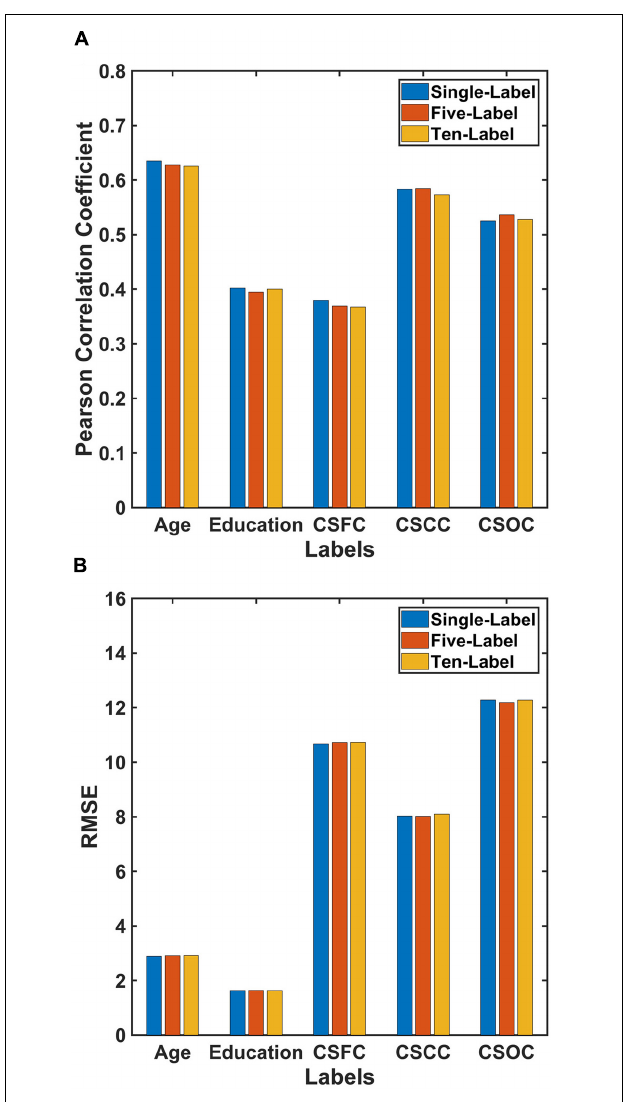
FIGURE 3 | Comparison of the performances of PLSR for single- and multi-label learning. The reported values were (A) Pearson correlation coefficient and (B) RMSE. The performances of the single-label PLSR were comparable to those of the multi-label PLSR, and adding additional five labels into the model had limited effect upon the estimation